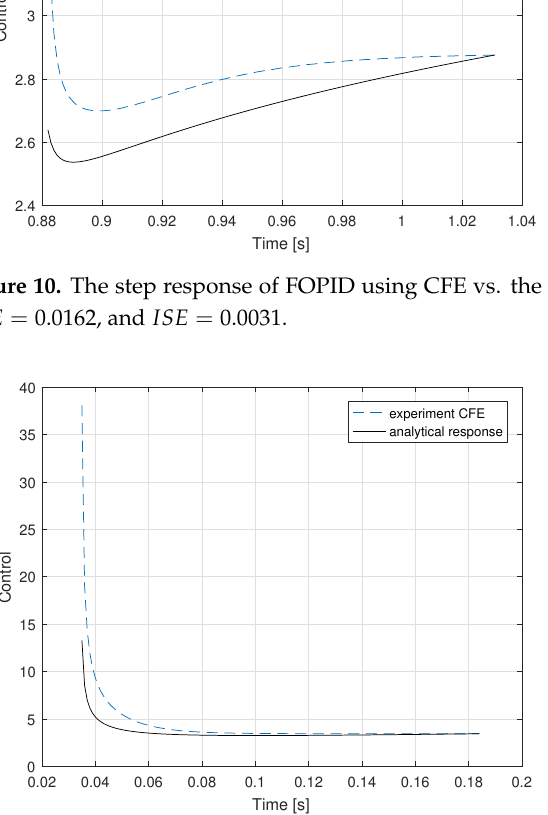
Figure 11. The step-response of FOPID using CFE vs. the analytical response, α = 0.5, β = 0.5. IAE = 0.1176, and ISE = 0.9345.